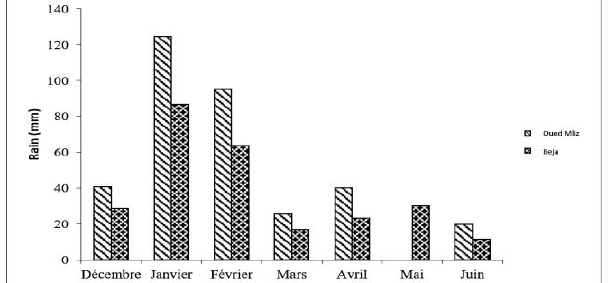
Figure 1: Rainfall for the period experimental growing season in the two